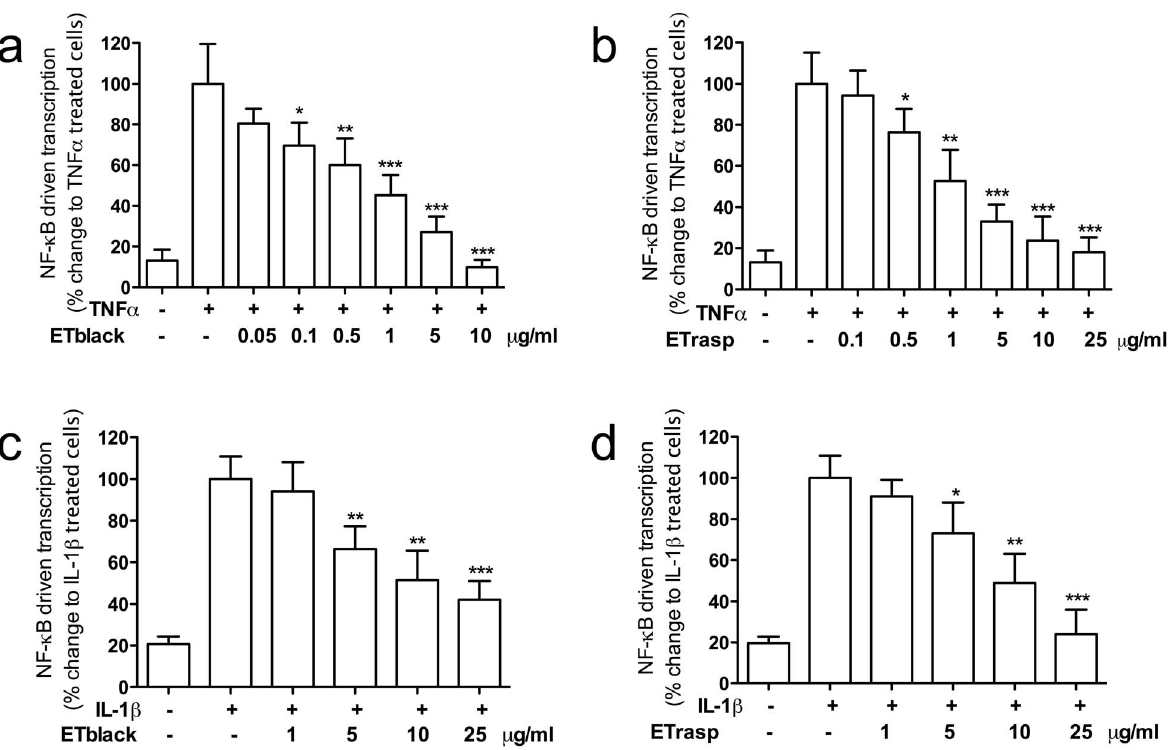
Figure 3. Effect of ETs from blackberry and raspberry on NF- k B driven transcription induced by TNF a and IL-1 b . AGS cells at confluence were placed in a medium deprived of FCS, and stimulated with 10 ng/ml TNF- a (panel a and b) or (panel c and d) for 6 hrs. ETs were tested at 1–10 m g/ml; individual compounds at 0.5–10 m M. After 6 hours cells were harvested and luciferase assays were performed using Britelite TM Plus reagent (PerkinElmer Inc. Massachusetts, USA) according to manufacturer’s instructions. Inhibition by 5 m M parthenolide, used as reference inhibitor, was 72% on TNF- a induced NF- k B driven transcription, and 71% on IL-1 b induced NF- k B driven transcription. Results are the mean 6 sd of three experiments in triplicate. * p , 0.05, ** p , 0.01, ***p , 0.001.